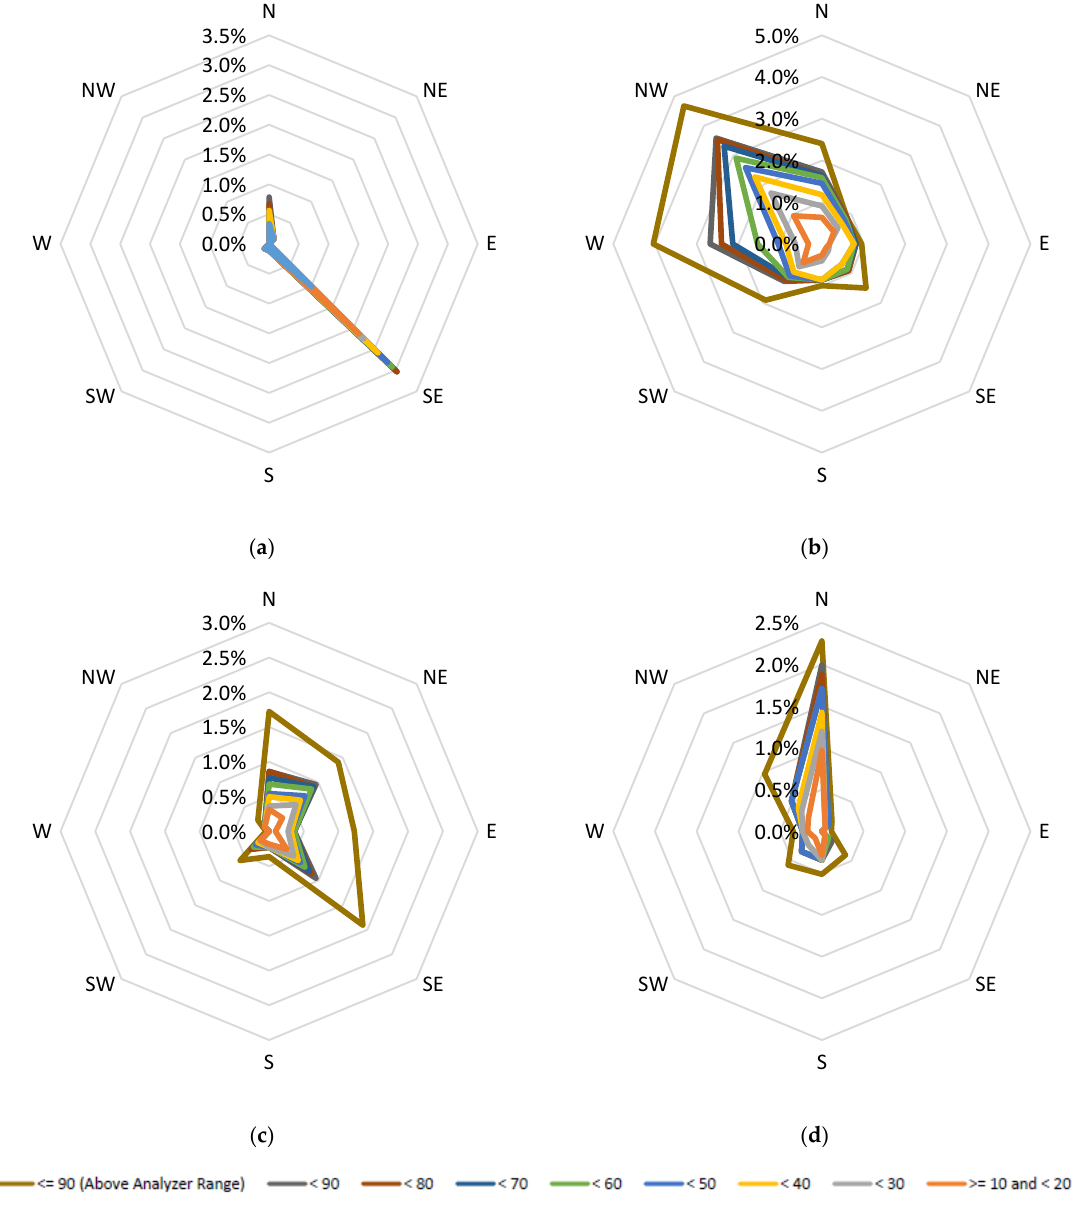
Figure 5. Cumulative frequency (% of monitored time) that hydrogen sulfide concentration measurements (ppb) were greater than or equal to 10 ppb and less than the upper ranges specified in the legend, at the monitoring locations for the dairy case study: ( a ) NW of the dairy; ( b ) near the manure storage of the dairy; ( c ) SW of the dairy; and ( d ) SE of the dairy. Note: Hydrogen sulfide concentrations less than 10 ppb are excluded from this figure to highlight the patterns for higher concentration measurements, more likely to trigger odor